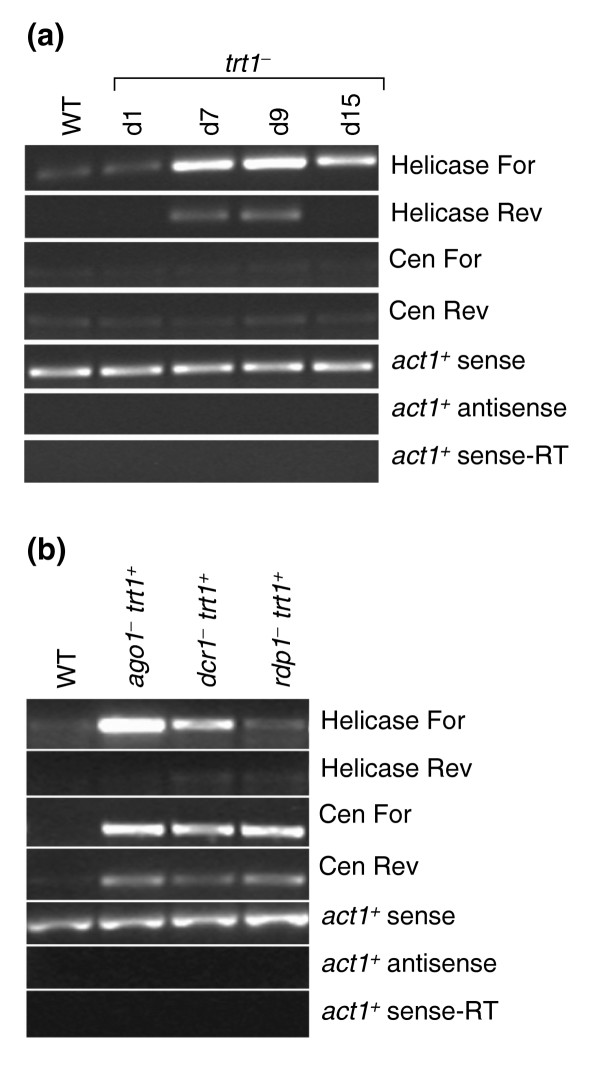
Expression of dh repeats at the sub-telomere. (a) Expression of sub-telomeric dh repeats in trt1- mutants. Strand-specific RT-PCR using primers spanning the region of dh repeats in the putative helicase (Pdh in Figure 6) was used to detect the expression of both forward (For) and reverse (Rev) transcripts. We define the forward transcript to be homologous to the DNA strand running towards the chromosome end in the 5' to 3' direction (this is also the strand with the longest ORF). Strand-specific control reactions were also performed using primers specific for centromeric (Cen) dh repeats [33], as well as act1+ sense and act1+ antisense transcripts (a control lacking reverse transcriptase is labeled -RT). Strains WT 5 and days 1, 7, 9 and 15 of the growth curve are shown. (b) Expression of sub-telomeric dh repeats in RNAi mutants. RNA was isolated from trt1+ RNAi mutant strains ago1-, dcr1- and rdp1- [33], and subjected to strand-specific RT-PCR using the same primers described in (a). A different wild-type strain from that in (a) was used.